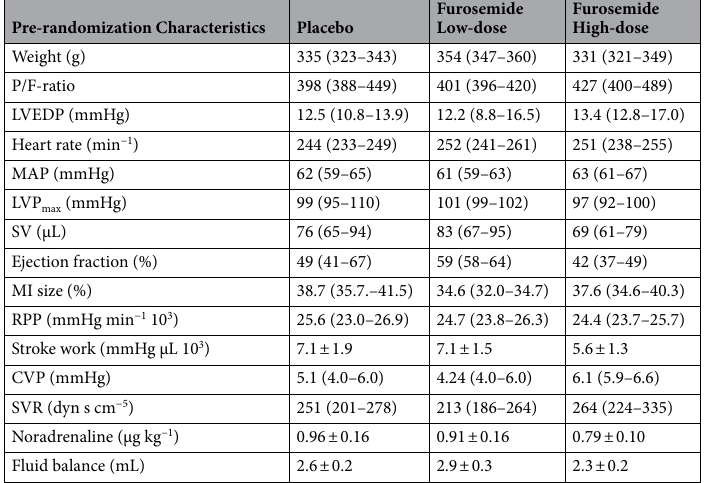
Table 1. Characteristics at randomization. Data presented as median (IQR) or mean ± SD.